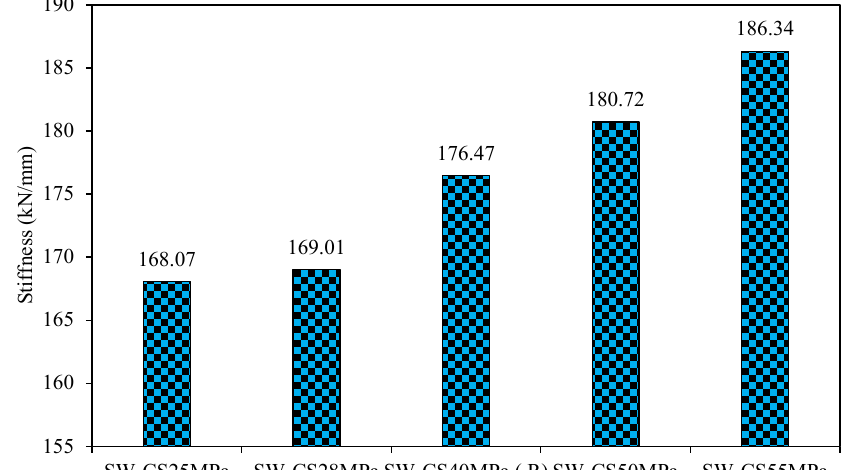
Figure 15. Stiffness of group Figure 15. stiffness of group 2.